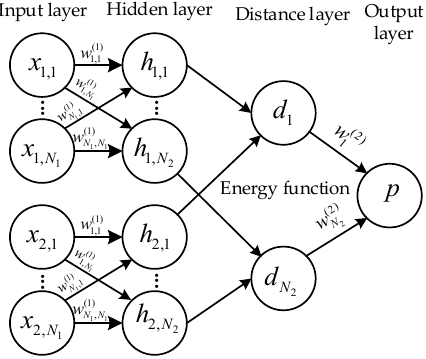
Figure 1. The framework of Siamese neural network. A pair of parallel networks extract features separately, and an energy function connects them to measure a certain relationship between two features.